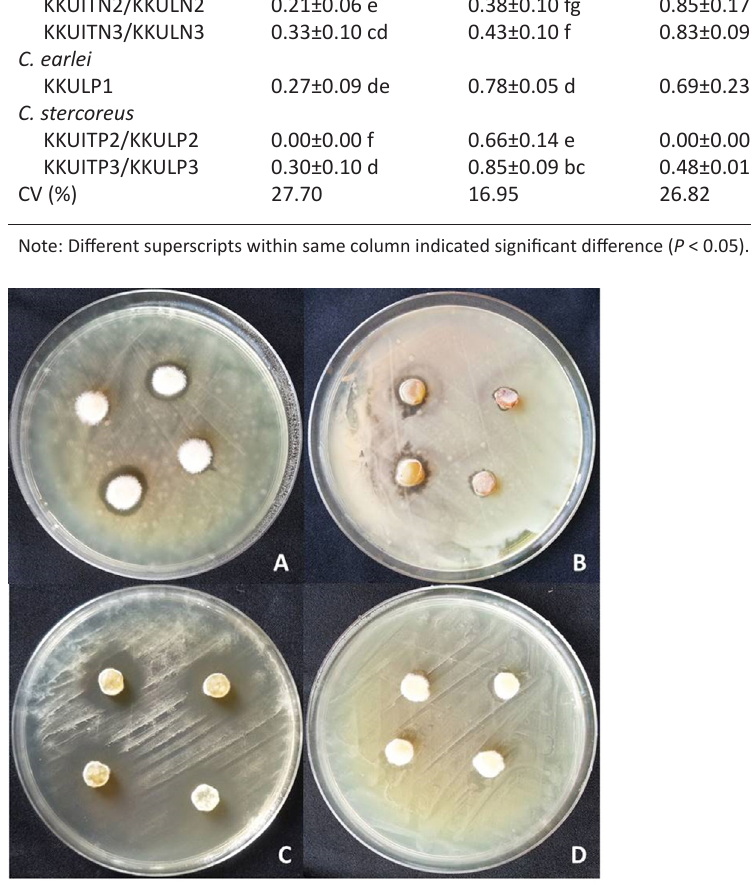
Fig. 1. Efficacy of Cyathus sp. controlling plant pathogenic bacteria by dual culture technique. A: C. striatus KKU4 + Pectobacteria sp., B: C. striatus KKU6 + Pseudomonas sp., C: C. pallidus KKUITN3/KKULN3 + Ralstonia solanacearum , D: C. striatus KKU3 + Xanthomanas campestris pv. vesicatoria